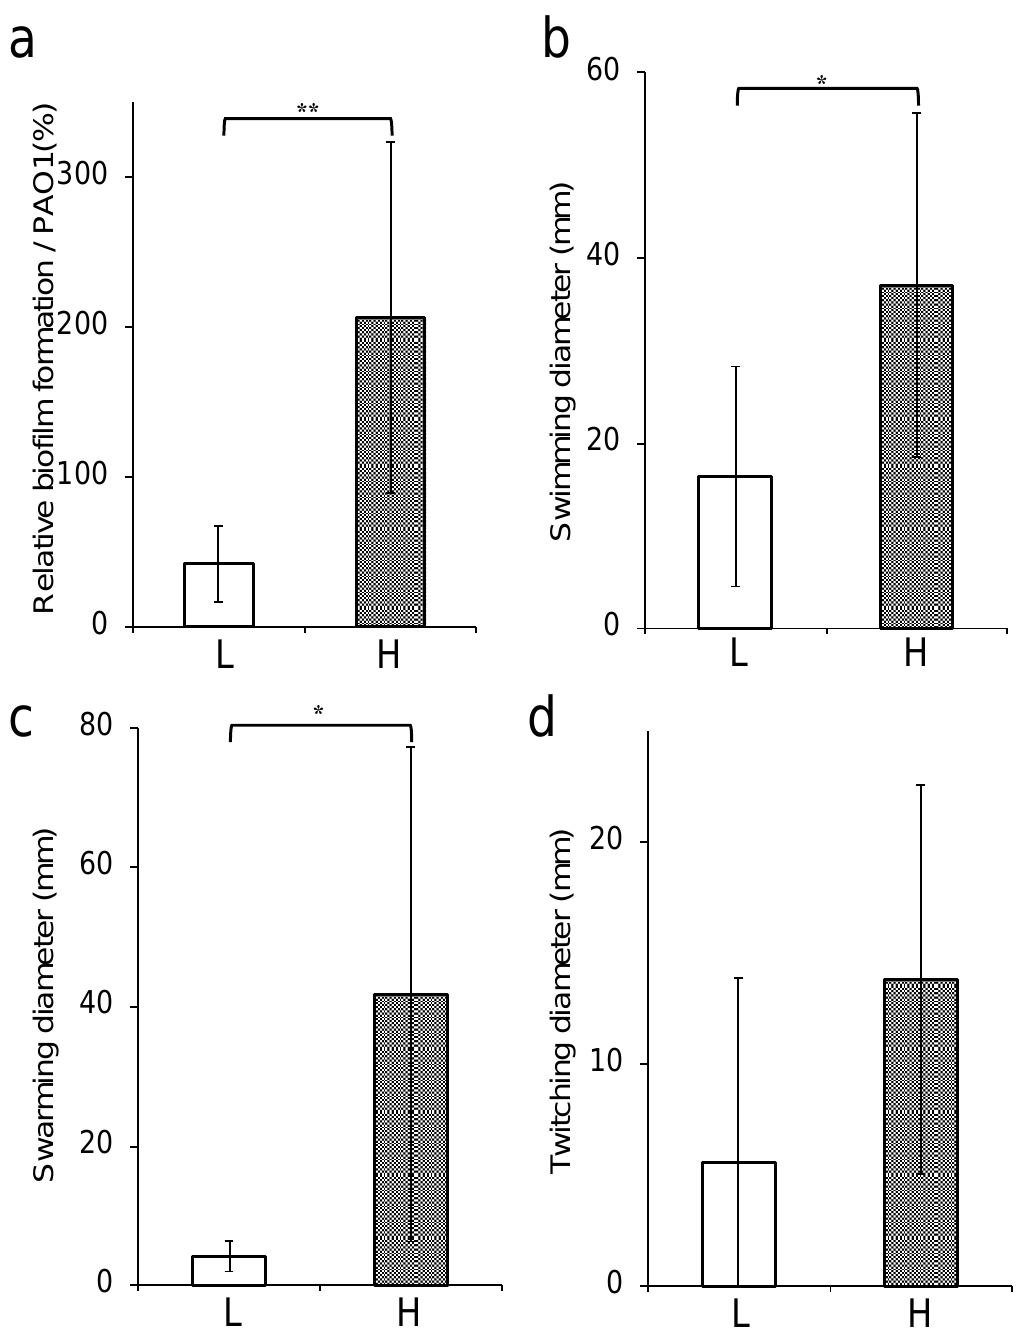
Figure 5. Bacterial biofilm formation and motility activities of the low- and high-tolerance groups. Relative biofilm formation ( a ), swimming motility ( b ), swarming motility ( c ), and twitching motility ( d ) are shown. The white bars represent the low-tolerance group ( n = 6), and the black bars represent the high-tolerance group ( n = 9). Each experiment was performed in triplicate. The data are presented as the mean ± SD for three experiments (* p < 0.05, ** p < 0.01 compared to the low-tolerance group).